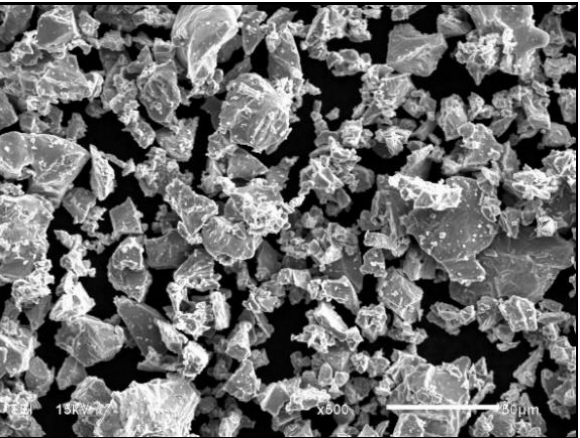
Figure 4 . An SEM (scanning electron microscope) image at 500× magnification of the −45 µm Ti- Figure 4. An SEM (scanning electron microscope) image at 500 × magnification of the − 45 µ m Ti-HDH powder used in this study. HDH powder used in this study.